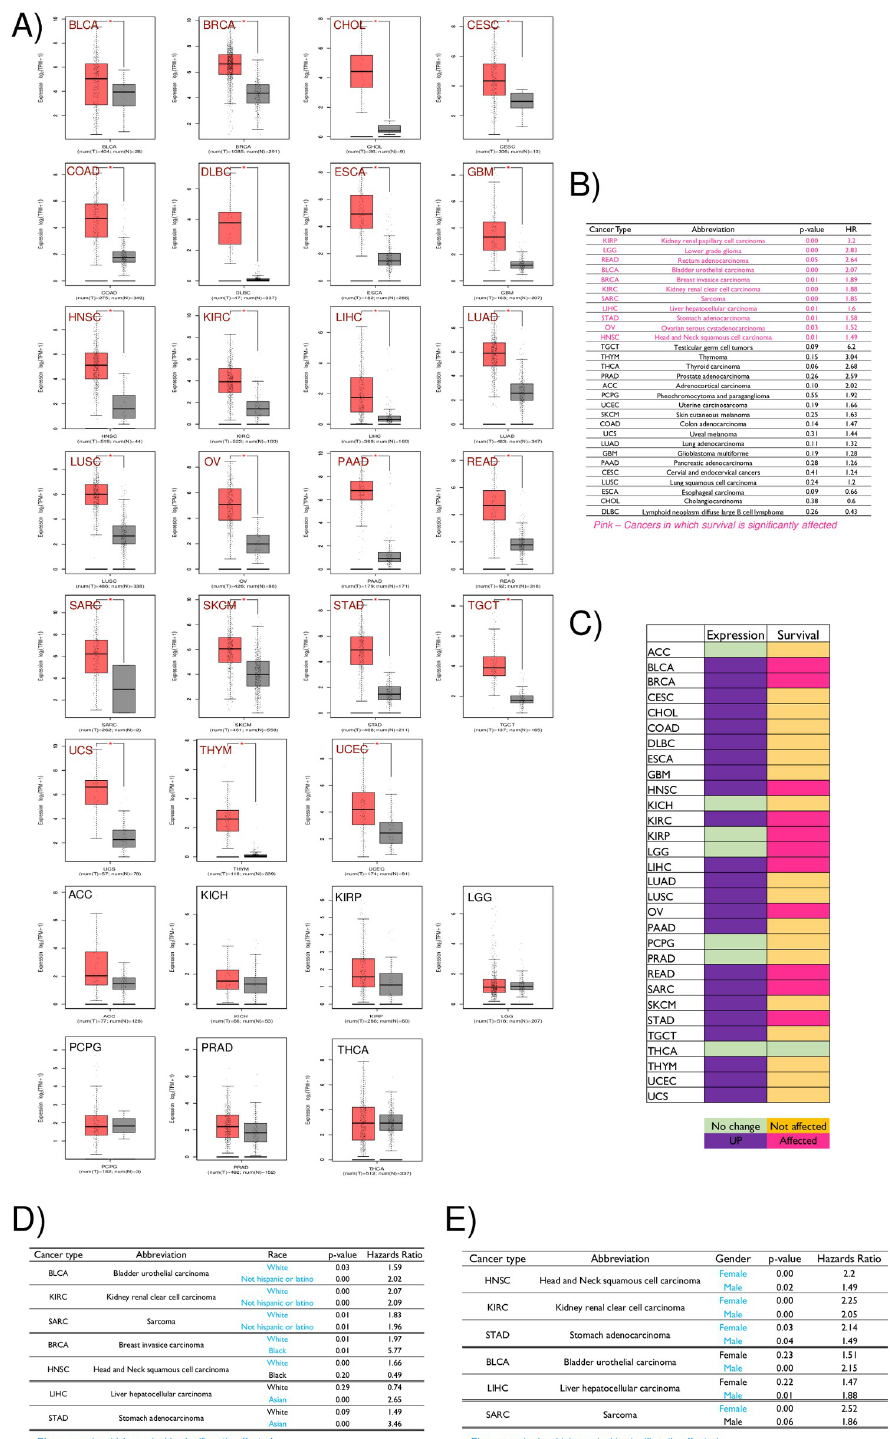
Fig 3. Pan-cancer analysis of CTHRC1 expression and its effect on survival. A) Graphs represent CTHRC1 expression data from the GEPIA2 portal in 30 different tumour types (T–RED bar) relative to normal (N–GREY bar). Cancers showing significant upregulation in CTHRC1 are listed first and labelled in RED. Those showing no significant change in expression are listed later and labelled in BLACK. Expression data are represented as mean ± standard deviation (S.D) on a log scale using a box plot. p-value of < 0.05 was determined as statistically